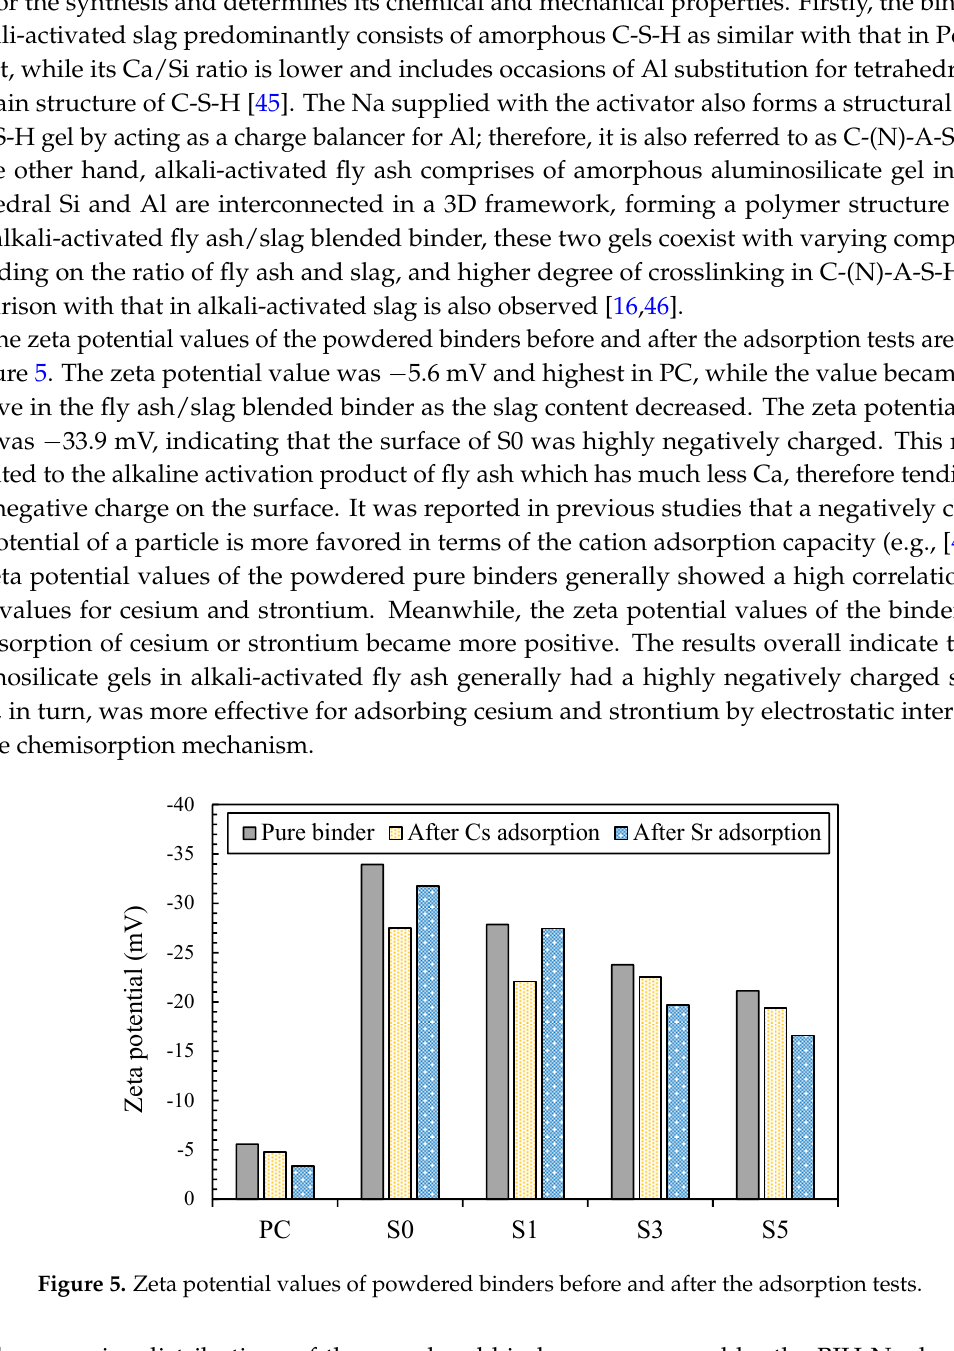
Table 5. Pore characteristics of powdered binders.